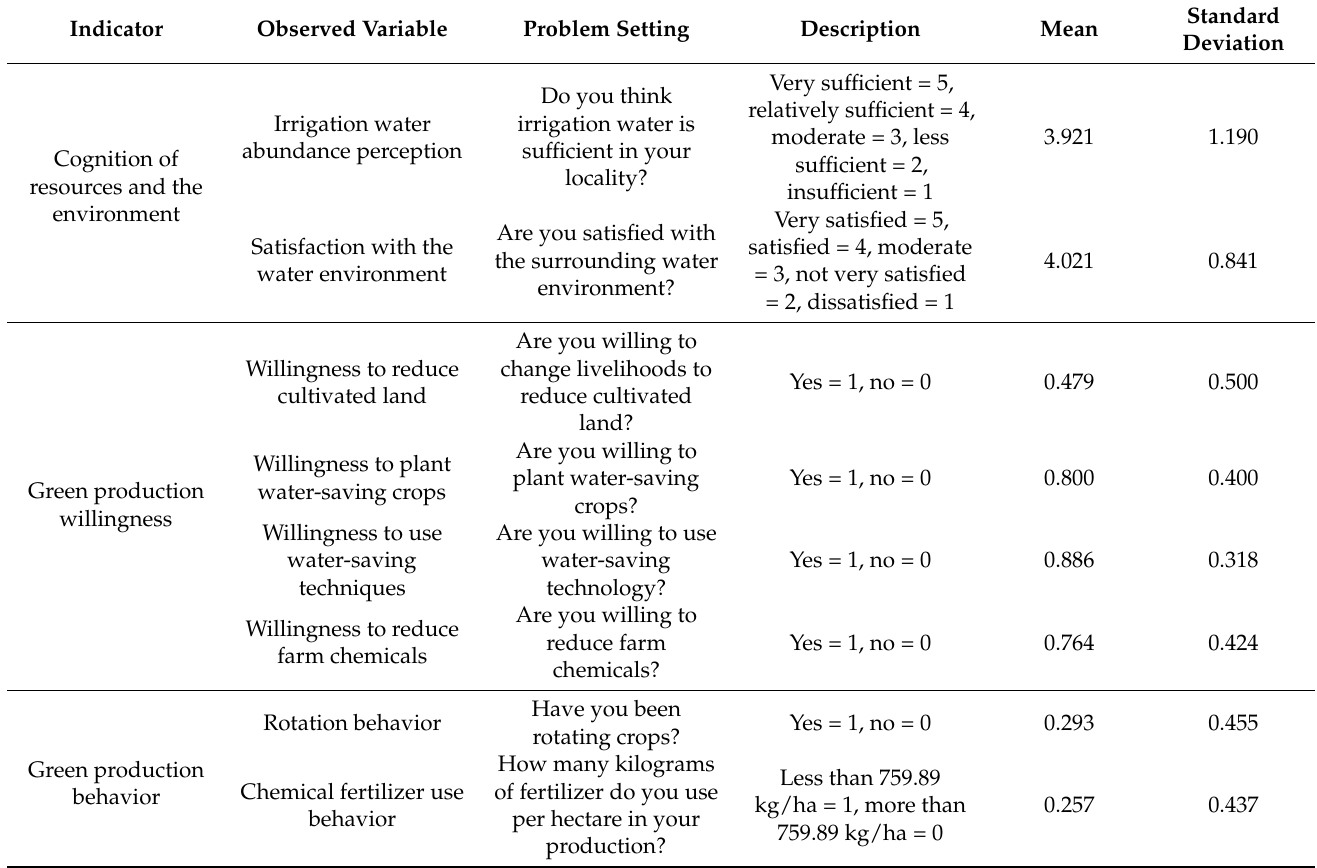
Table 1. Settings and variables of the questionnaire.